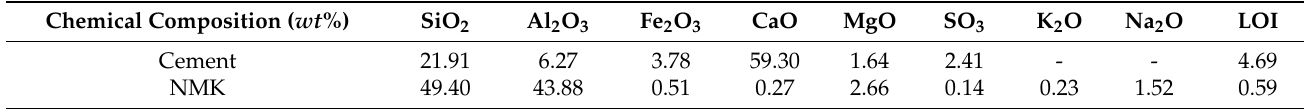
Table 1. The chemical composition of NMK and